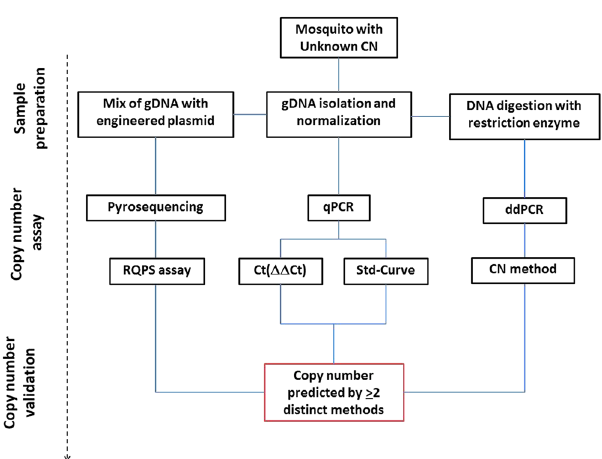
Figure 2. Schematic depicting the different approaches applied for genotyping and validation of the Vgsc gene CN in C . quinquefasciatus mosquitoes. qPCR-Std-curve and ddPCR-CN method applied an absolute quantification measurement, while qPCR- ΔΔ Ct and pyrosequencing-RQPS use a relative CN quantification. RQPS: Reference Query pyrosequencing. ddPCR: Droplet Digital PCR. Ct: intersection between an amplification curve and a threshold